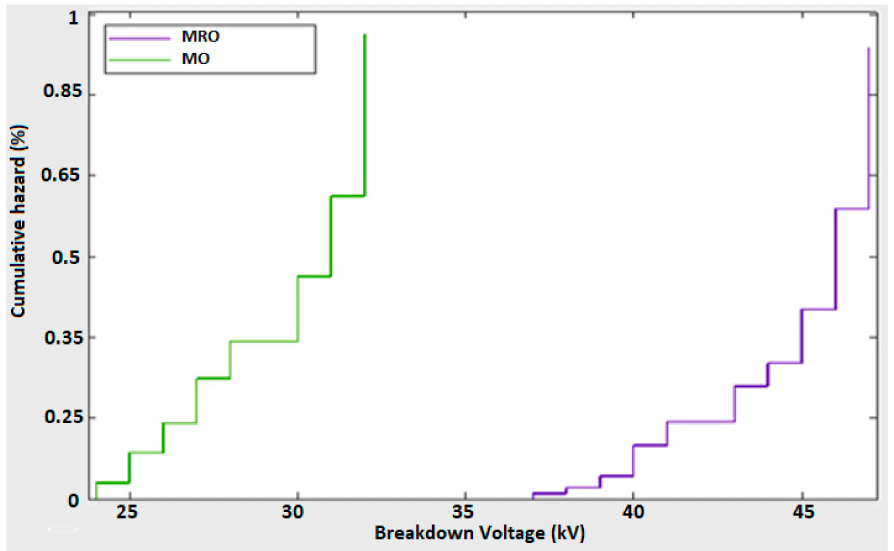
Figure 4. Cumulative hazard of MRO and MO showing the integral of hazard function H(x) = − ln(1 − f(x)) which shows the probability of failure at time x has given survival until time x.